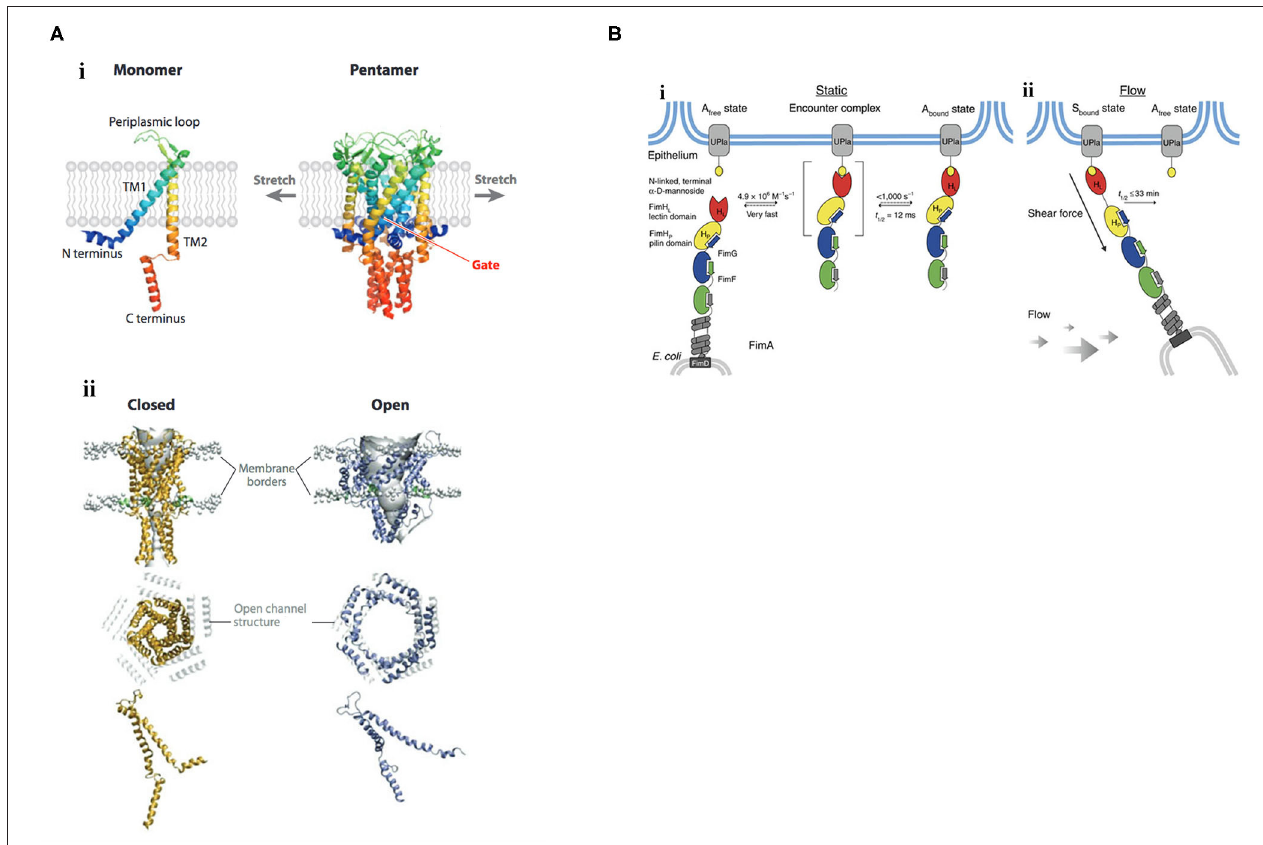
FIGURE 1 | Mechanisms of mechanosignaling in bacteria. (A) Structure and gating mechanism of MscL. (i) X-ray structure of the MscL from Mycobacterium tuberculosis. The channel monomer (left) is composed of two α -helical TM domains, TM1 and TM2; cytoplasmic N- and C-terminal domains; and a central periplasmic loop. The five TM1 domains form a tightly packed bundle funneling to a hydrophobic constriction, functioning as the gate (right). (ii) Three-dimensional reconstruction of the pentameric MscL of E. coli viewed in the plane of the membrane (top) and from above (middle). The channel is shown in its closed (left) and open (right) states. In the top row, lipid phosphate headgroups are shown as gray balls to indicate the outer and inner borders of the membrane. The extent of rearrangement of a single MscL subunit from the closed to the open conformation is depicted at the bottom. Membrane tension flattens MscL in the direction of the pore axis due to an increased tilt in the TM1 and TM2 helices. Closed and open structures of MscL (middle) are superimposed on the open channel structure (depicted in gray). TM, transmembrane. Reprinted with permission from Kung et al. (2010). (B) Catch-bond mechanism of FimH-mediated cell adhesion. (i) In the absence of tensile mechanical force, formation of the FimH-Uroplakin 1a (UPIa) complex comprises the highly dynamic transition of the A free to the A bound state. Dissociation of the receptor from the FimH lectin domain in the A bound state is promoted via dynamic allostery by the pilin domain that acts as a negative allosteric regulator. (ii) Shear force increases the population of the S bound state of FimH, in which the pilin and lectin domains are separated. The dissociation of S bound under shear force is slowed down up to 100,000-fold compared with A bound . The indicated rate constants and half-lives correspond to the interaction between FimH F18 and the model ligand HM. Rate limiting reactions are indicated by solid arrows, and fast, non-limiting reactions by dashed arrows. Reprinted with permission from Sauer et al.